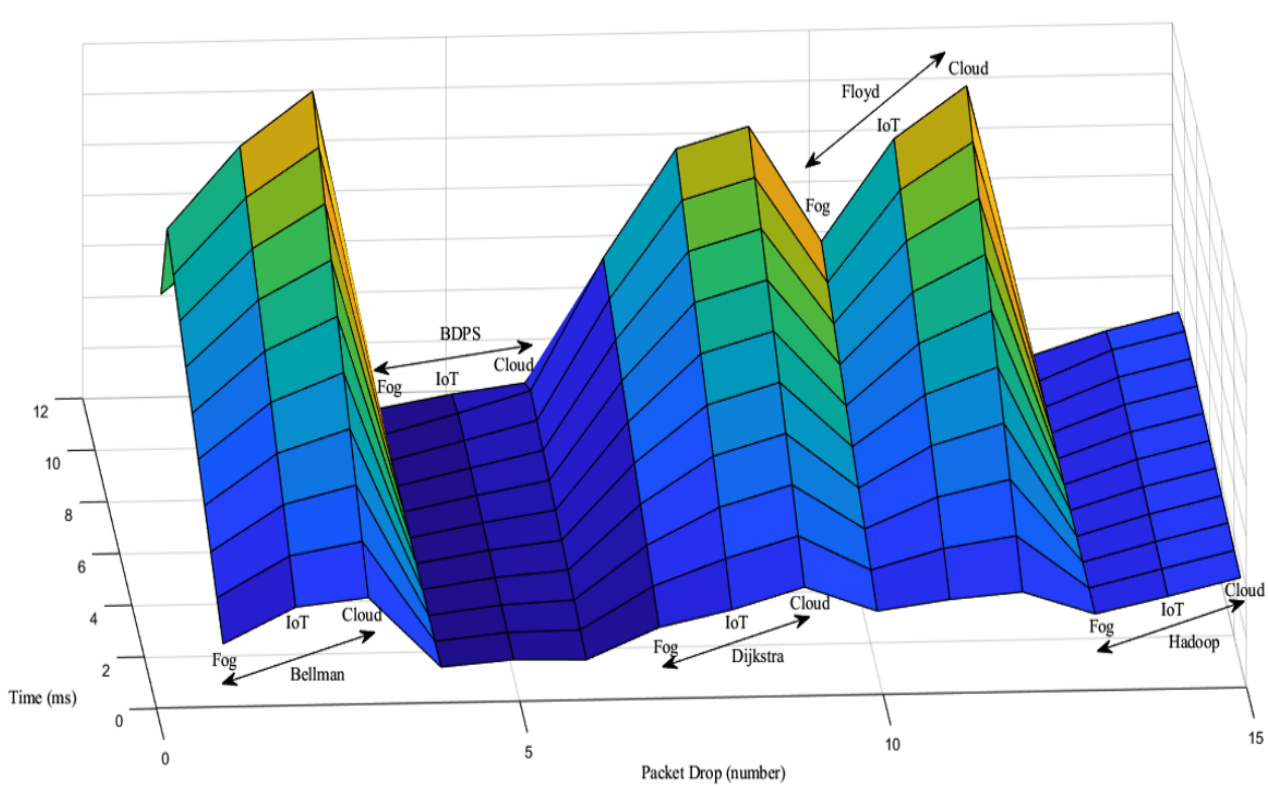
Figure 7. Packet drop generation scenario over the FW, AH, BF, DA and BDPS algorithms in cloud, fog and IoT